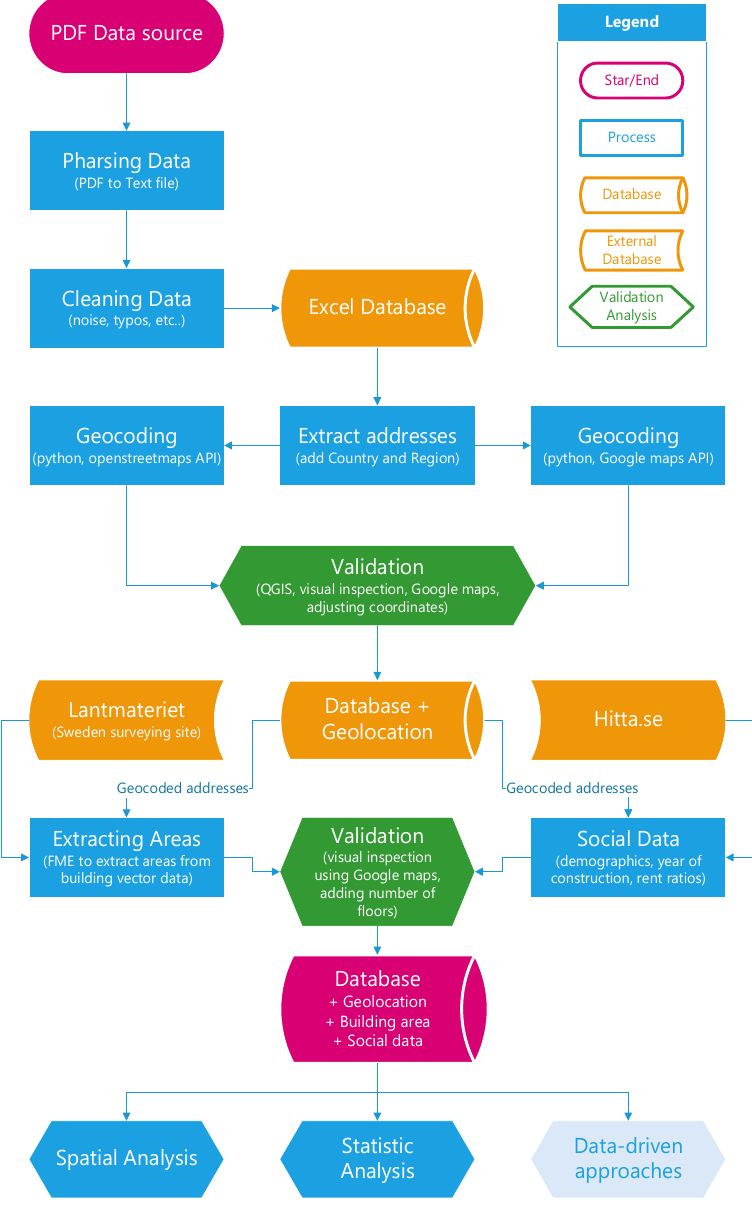
Figure 1. Flowchart for data processing, extraction, geocoding and